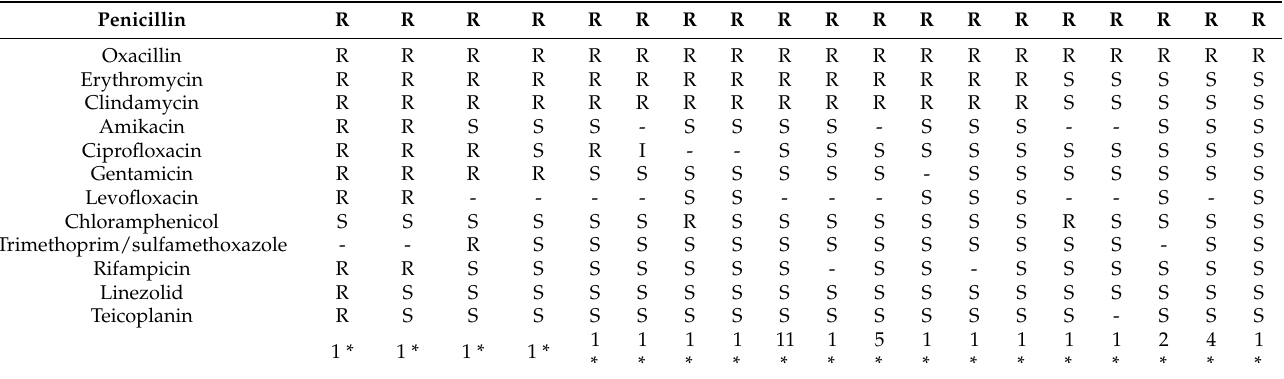
Table 9. Antibiotic resistance of the methicillin-resistant Staphylococcus aureus (MRSA) strains isolated from hospitalization samples (* no. of isolated strains).